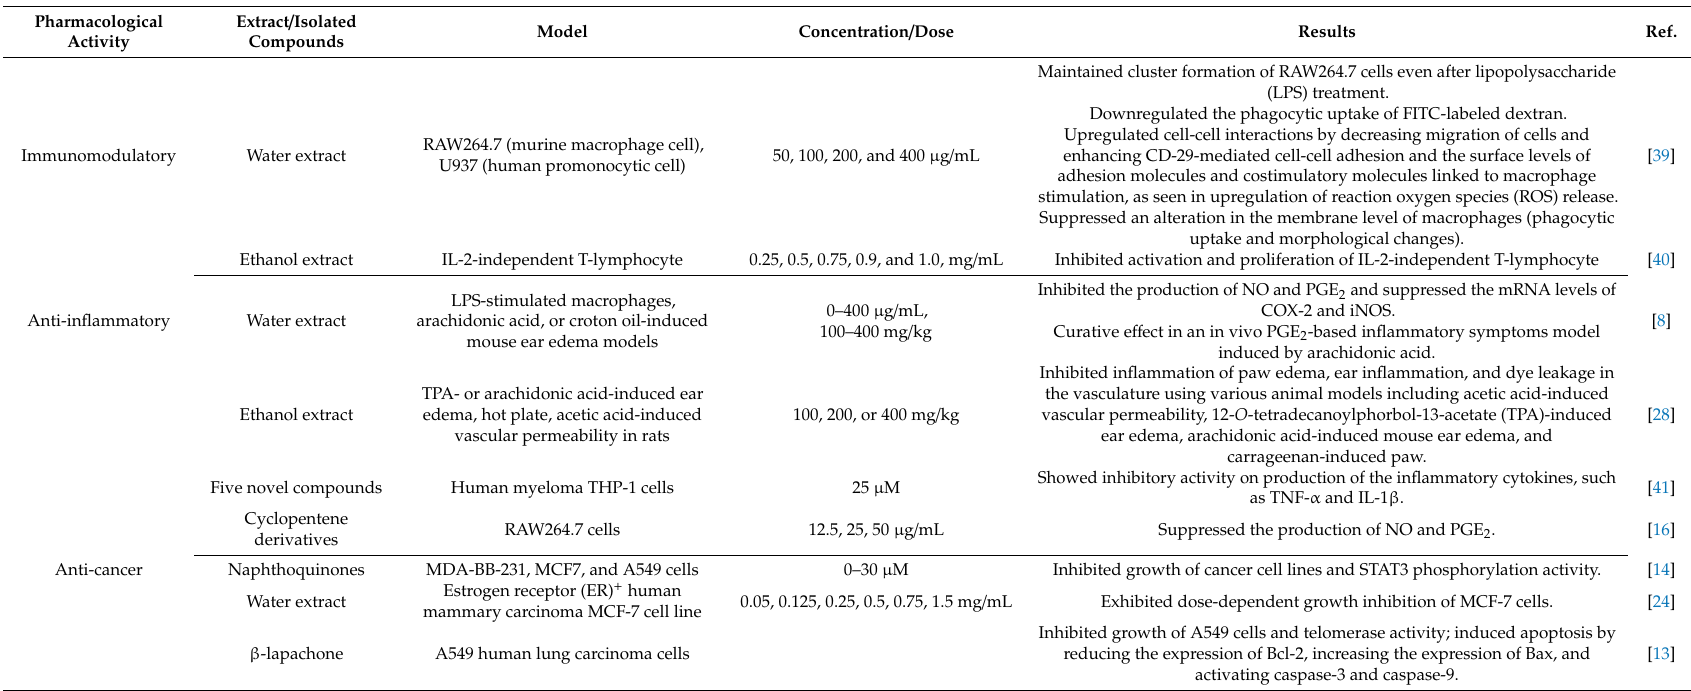
Table 3. Immunopharmacological e ff ects of Tabebuia